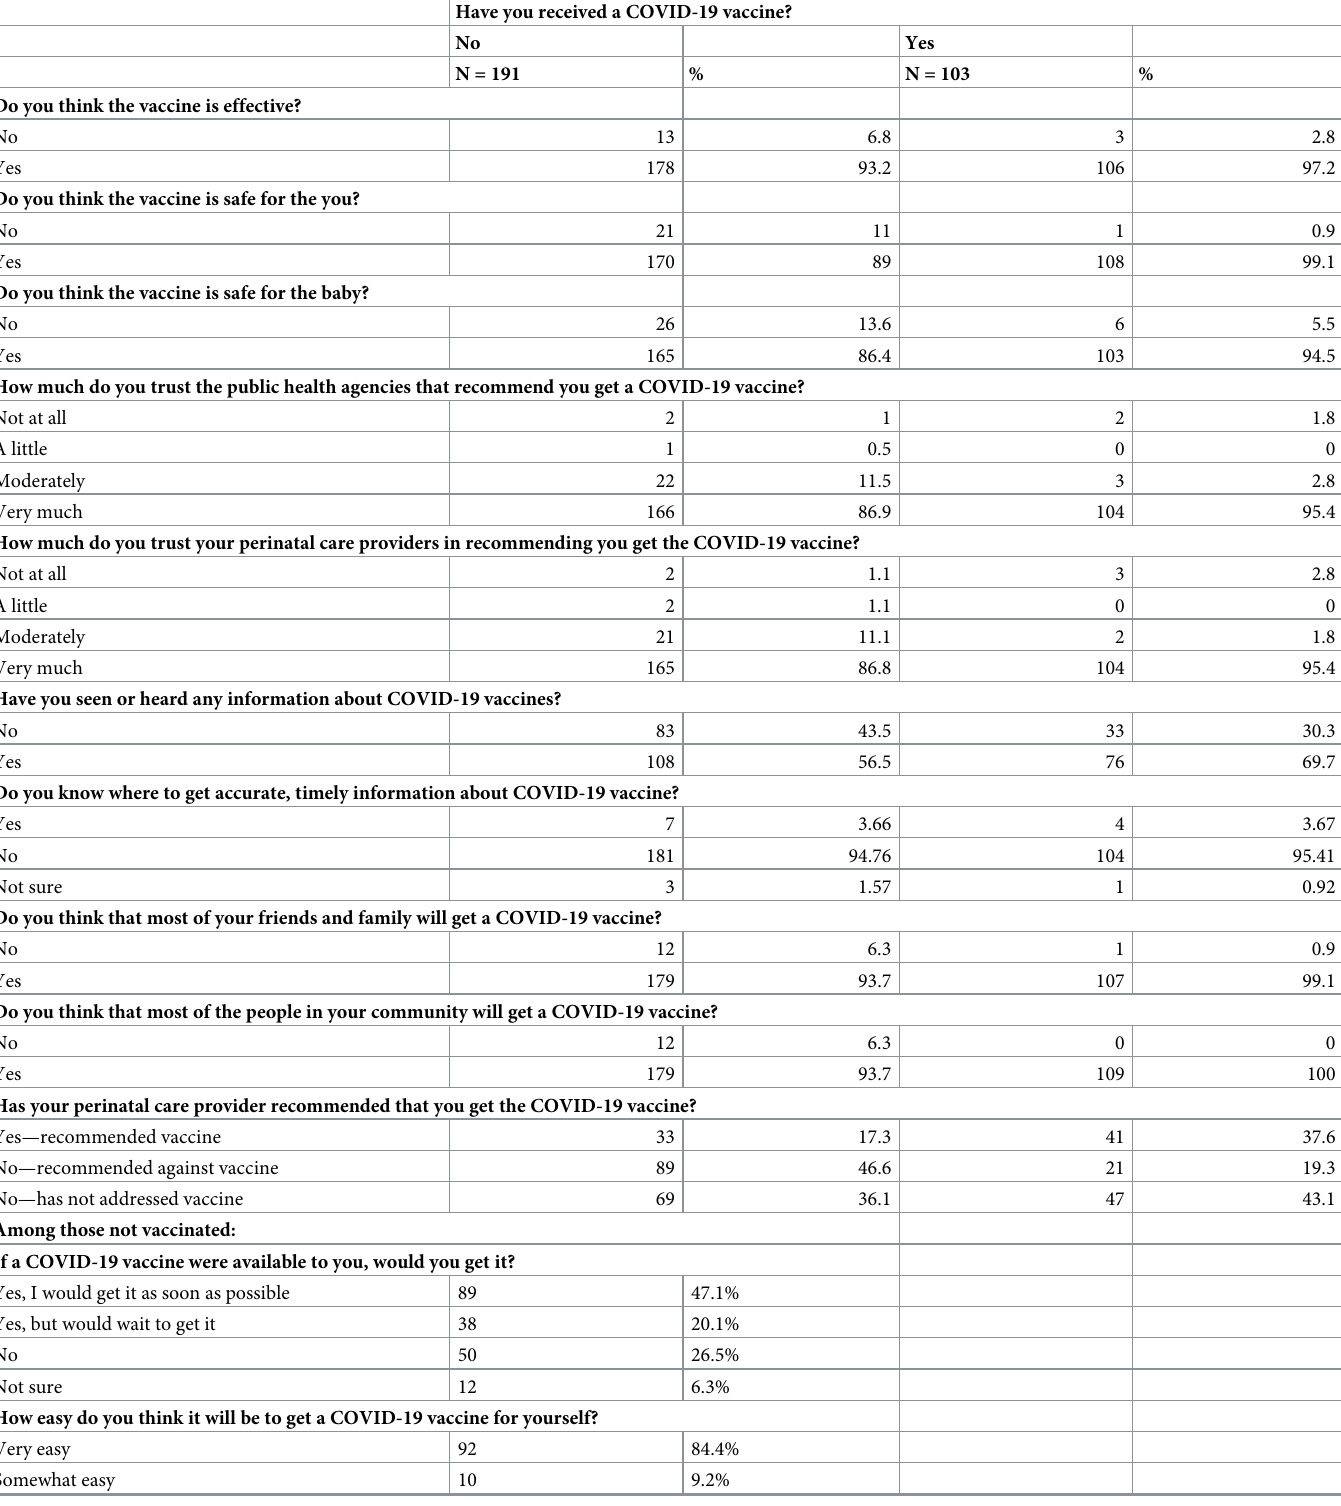
Table 2. Vaccination practices and beliefs.